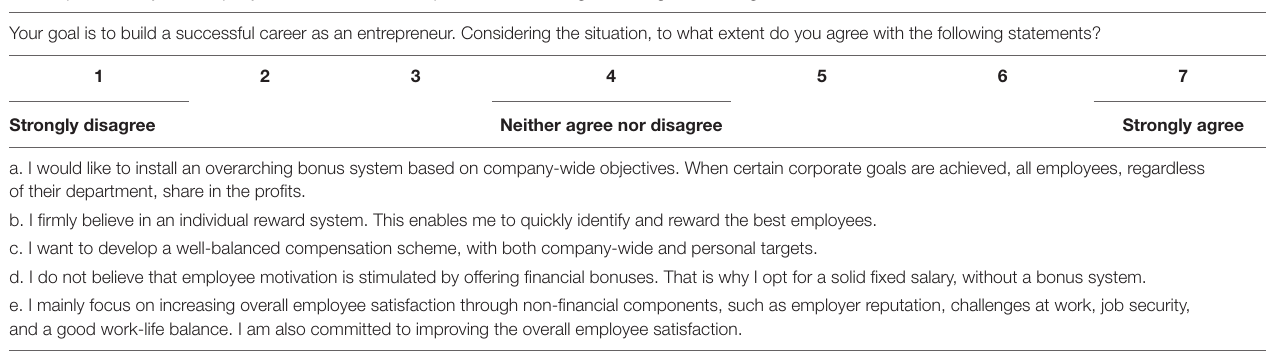
TABLE 1 | Example scenario with five